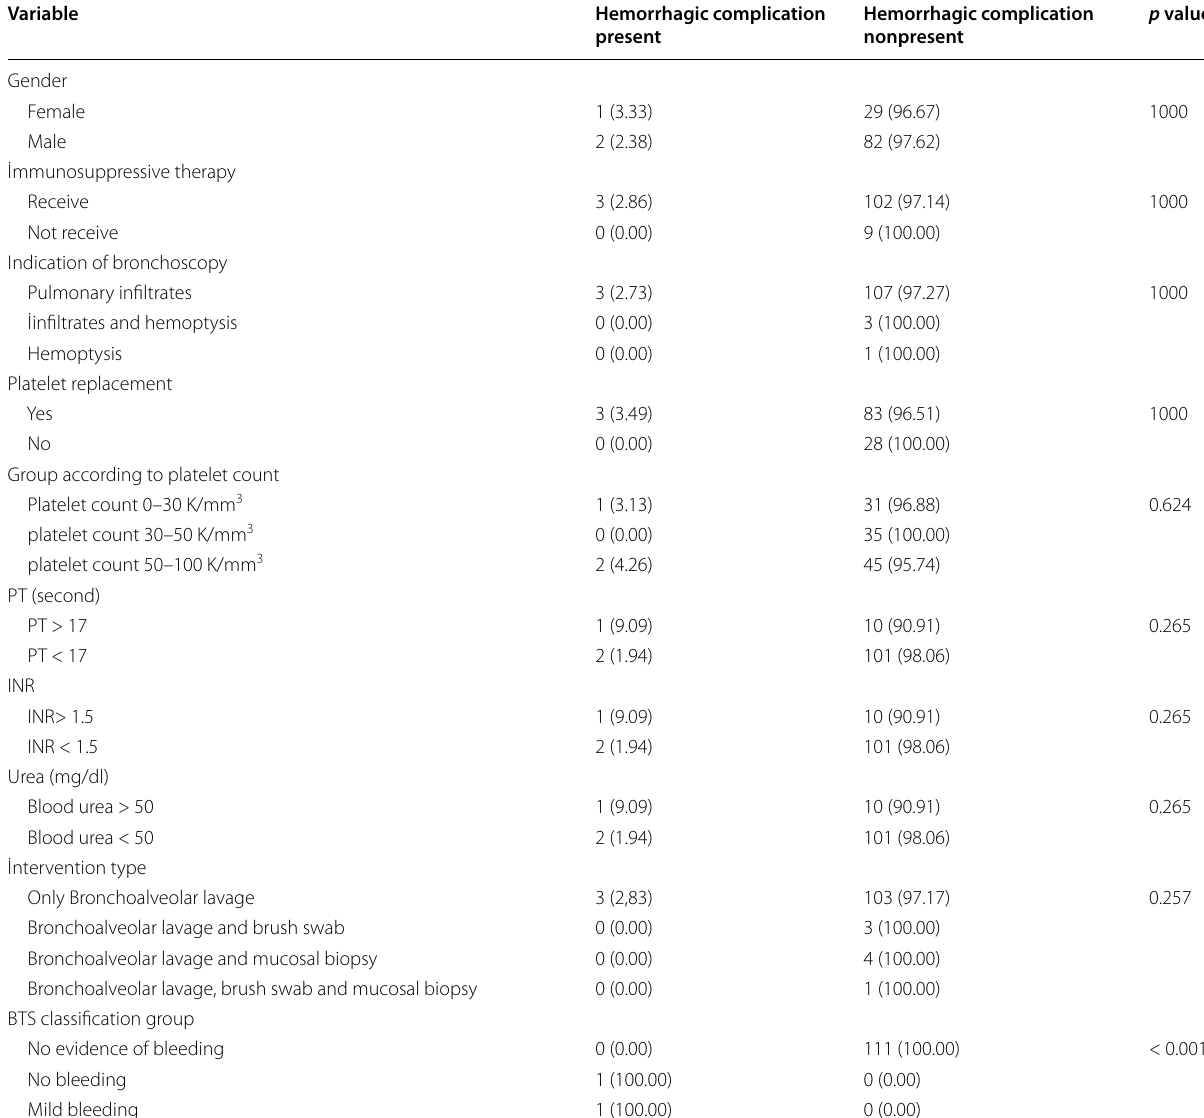
Table 1 Comparisons between various groups in terms of hemorrhagic complications